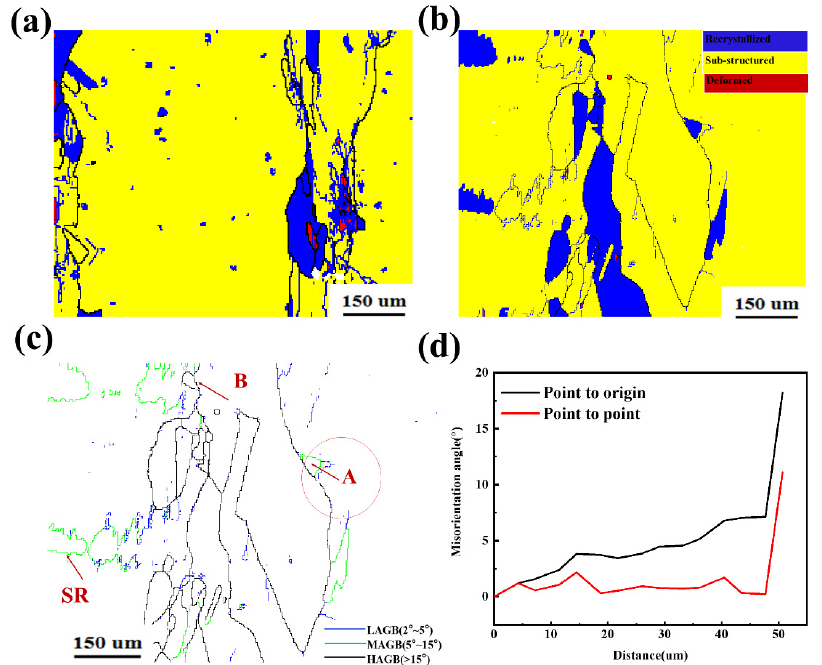
Figure 13. ( a ) Recrystallized fraction component map for the top zone; ( b ) recrystallized fraction component map for the bottom zone; ( c ) OIM map boundary distribution with HAGBs for black lines, LAGBs for blue lines, and MAGBs for green lines. SR, sub-grain rotation; B, bulging of grain boundaries; ( d ) misorientation analysis along line A marked in ( c ). The black line shows the misorientation between each point to the first point, and the red line indicates the misorientation from point to point along line A.